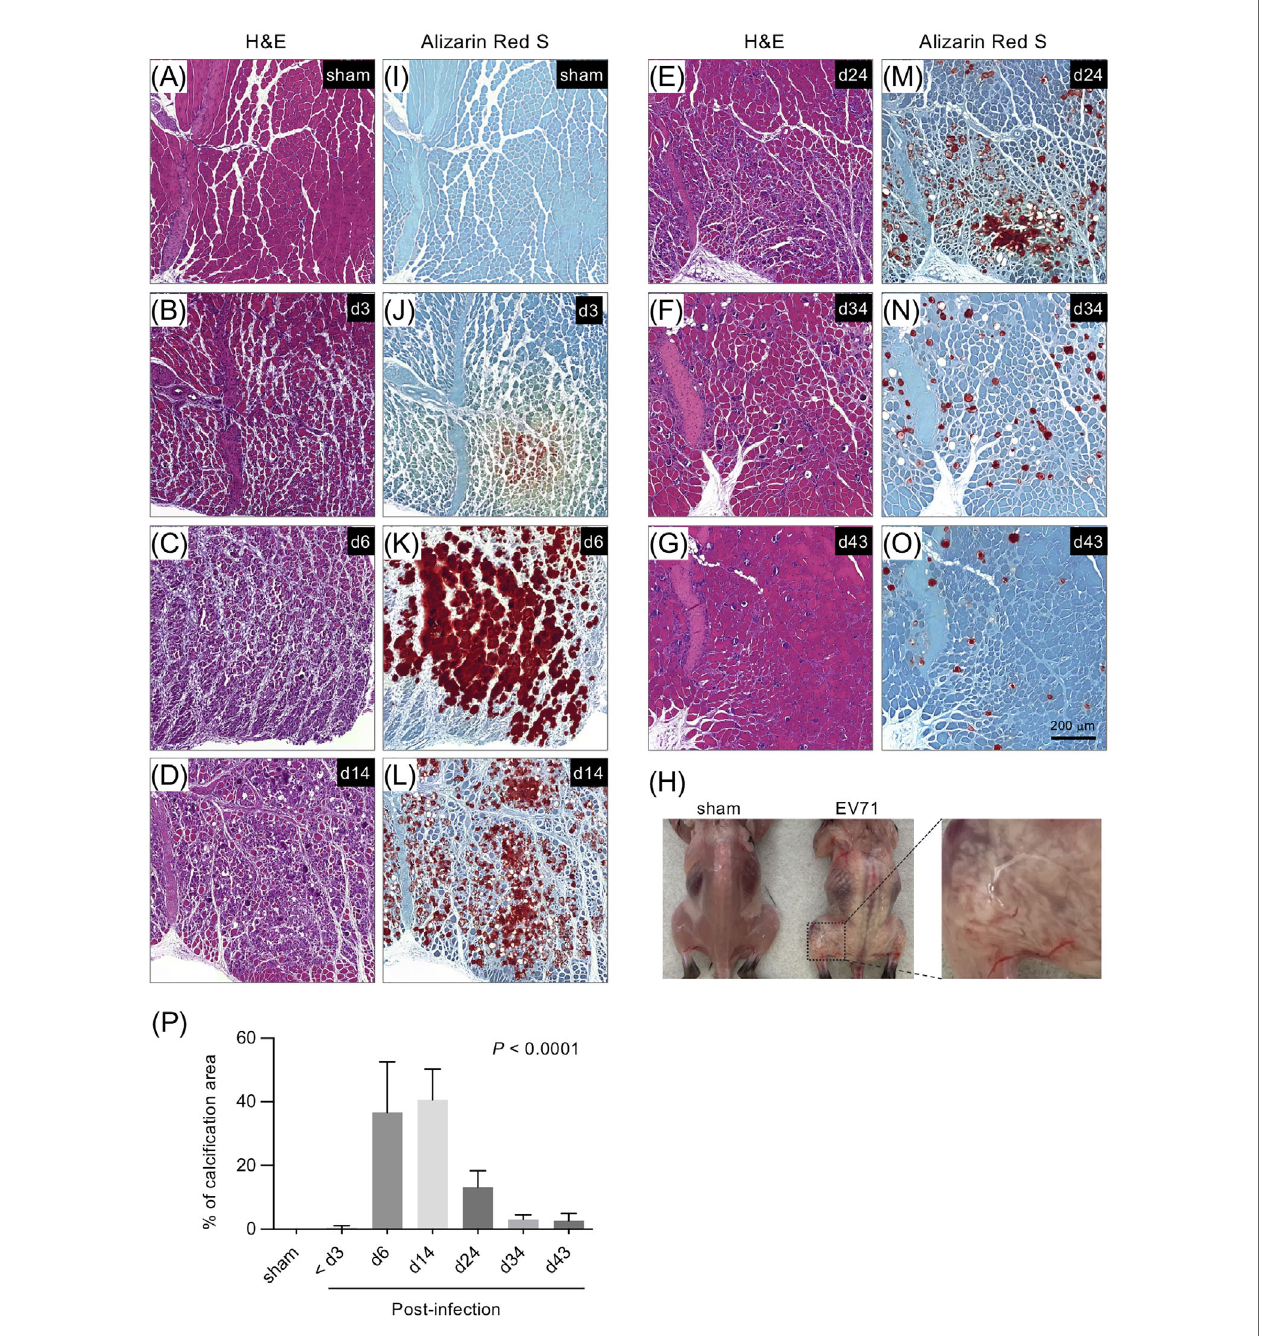
FIGURE 2 | Histopathological staining of the gastrocnemius muscle from EV71-infected mice. Gastrocnemius muscle sections from sham-infected or EV71-infected mice at day 3 (score = 1), day 6 (score = 3.5), day 14 (score = 1), day 24 (score = 0.5), day 34 (score = 0), and day 43 (score = 0) were stained with H&E staining (A-G) or Alizarin Red S staining (I-O) . (H) Photos of representative sham-infected and EV71-infected mice at day 8 post-infection (score = 3) are shown. The EV71- infected mouse (d8) showed a white appearance in muscles of body trunk and limbs. The magni fi ed image highlights the aberrant structure of muscles with white appearance. (P) The percentage of calci fi cation areas of muscles were measured and calculated as mentioned in Supplementary Figure 1 . The number of mice used for the quanti fi cation of image and their paralysis scores were indicated below: sham-infected (n = 2) or EV71-infected mice at day 3 (n = 3, score = 0, 0.5-1), day 6 (n = 2, score = 3.5), day 14 (n = 4, score = 0.5~1), day 24 (n = 3. score = 0.5~1.5), day 34 (n = 2, score = 0) and day 43 (n = 2, score = 0) post-infection. P value was calculated using one-way ANOVA. P <